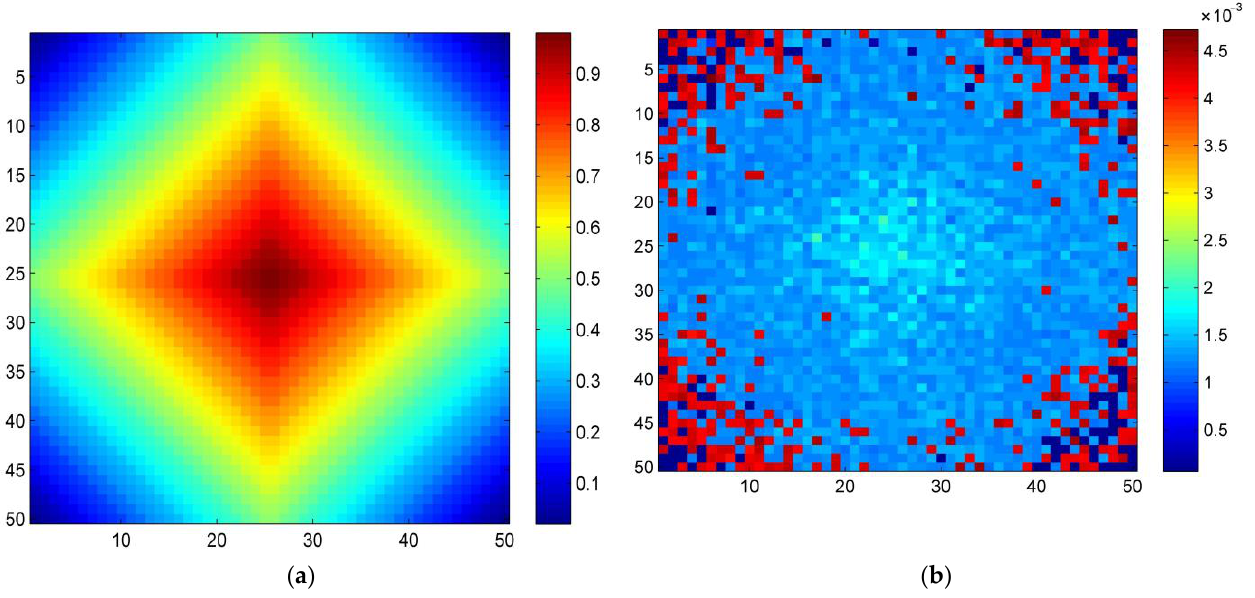
Figure 2. Spectral signatures of crude oil and seawater collected in laboratory by ASD spectrometer.